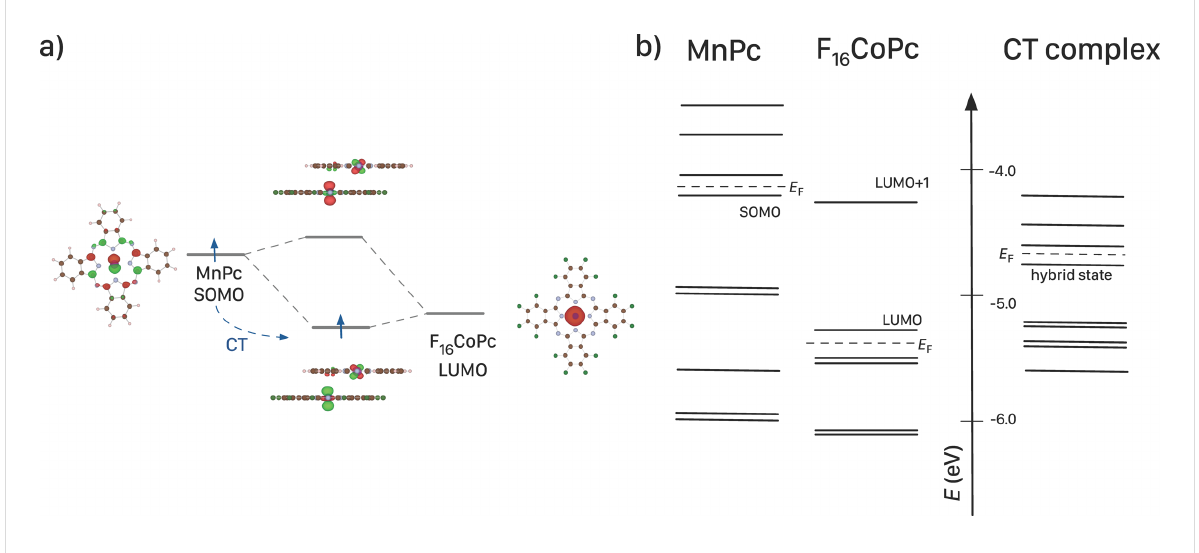
Figure 15: Results of the DFT calculations for the MnPc/F 16 CoPc model systems: a) The hybrid state is formed by the Mn 3d xz and the Co states. b) Comparison of the eigenvalues of the Kohn–Sham orbitals as obtained from the calculations for a single MnPc molecule, a single F 16 CoPc molecule and the dimer model